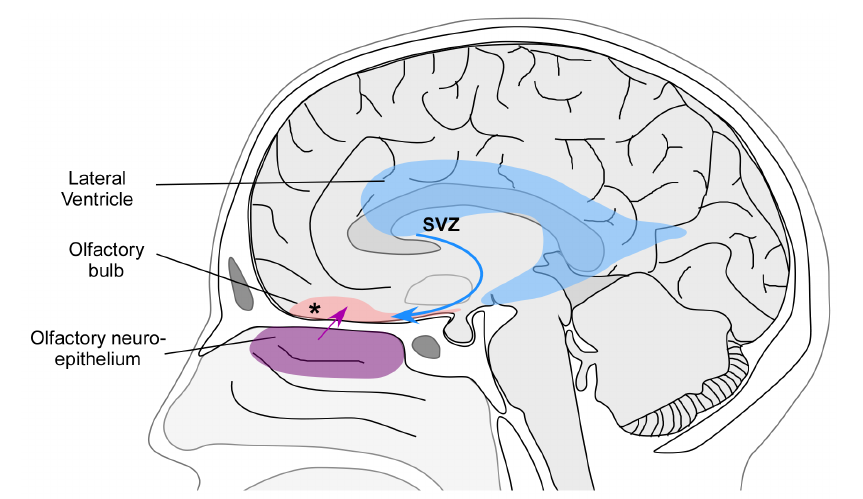
Figure 3. Mechanisms underlying the neurogenesis and plasticity of the olfactory